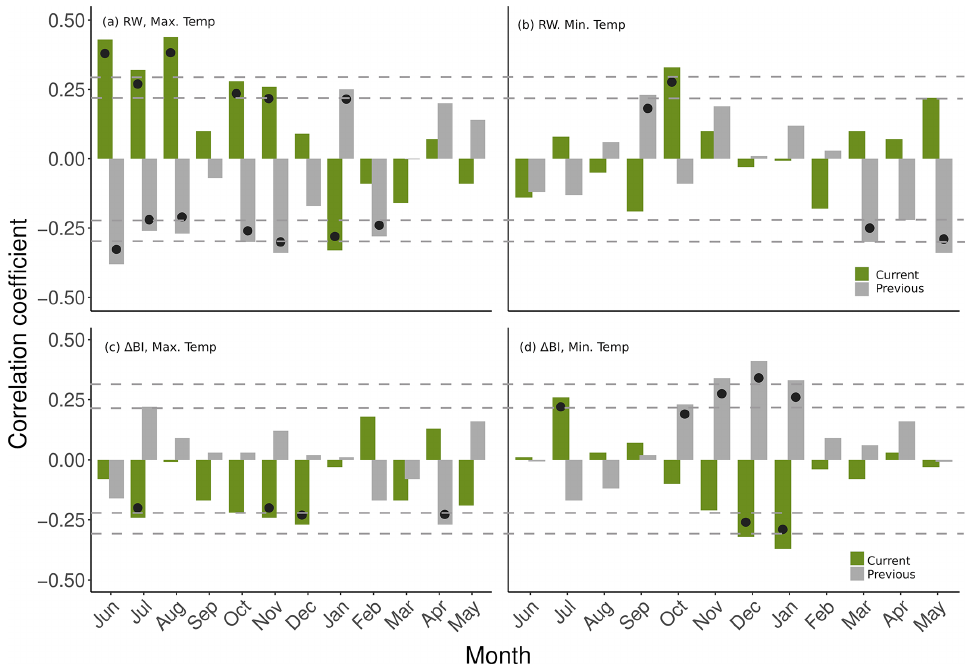
Figure 6. Correlations between RW and (cid:49) BI chronologies and mean minimum and maximum monthly temperature data from Omeo ob- servation station across the period 1929–1998, for both the current and previous growth year. Black dots indicate statistical significance ( p < 0 . 05), and dashed horizontal lines, with increasing distance from the x axis, indicate 0.05 and 0.01 significance levels. Radial growth of P. lawrencei occurs in summer months (approximately